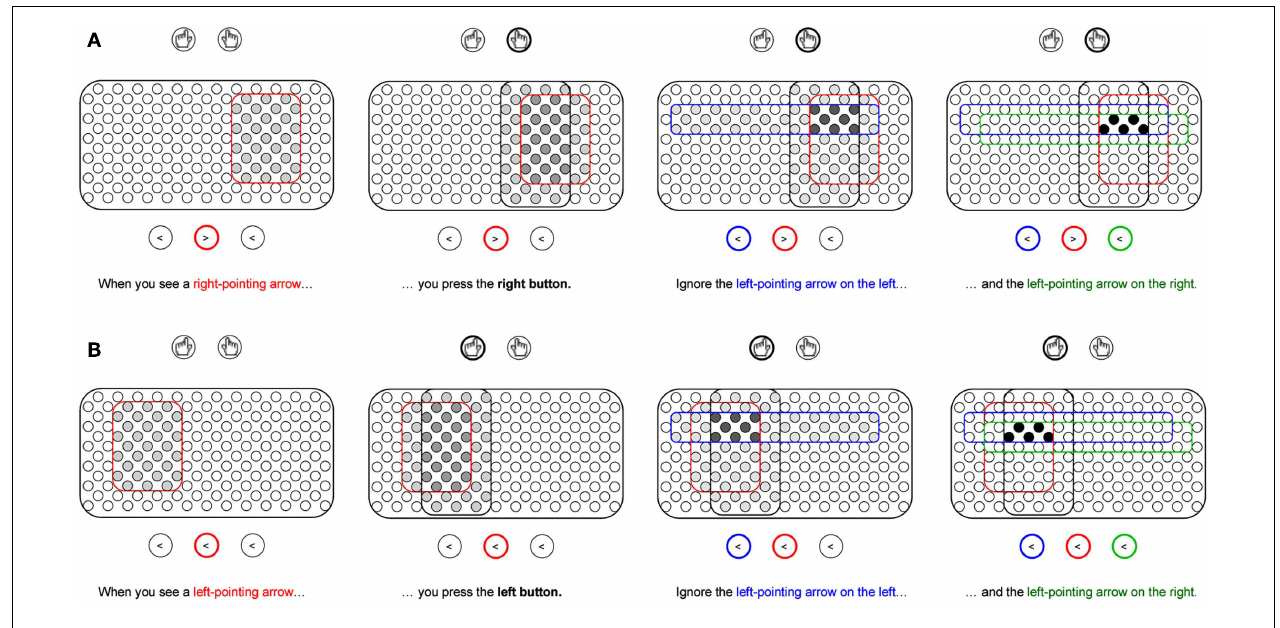
remain active and eventually become the representation of the instructed task rule. In the flanker task, target, response, and flanker information are bound into a single task representation.The example instructions are consistent across the two congruency conditions, even though in practice the flankers need not be ignored in congruent